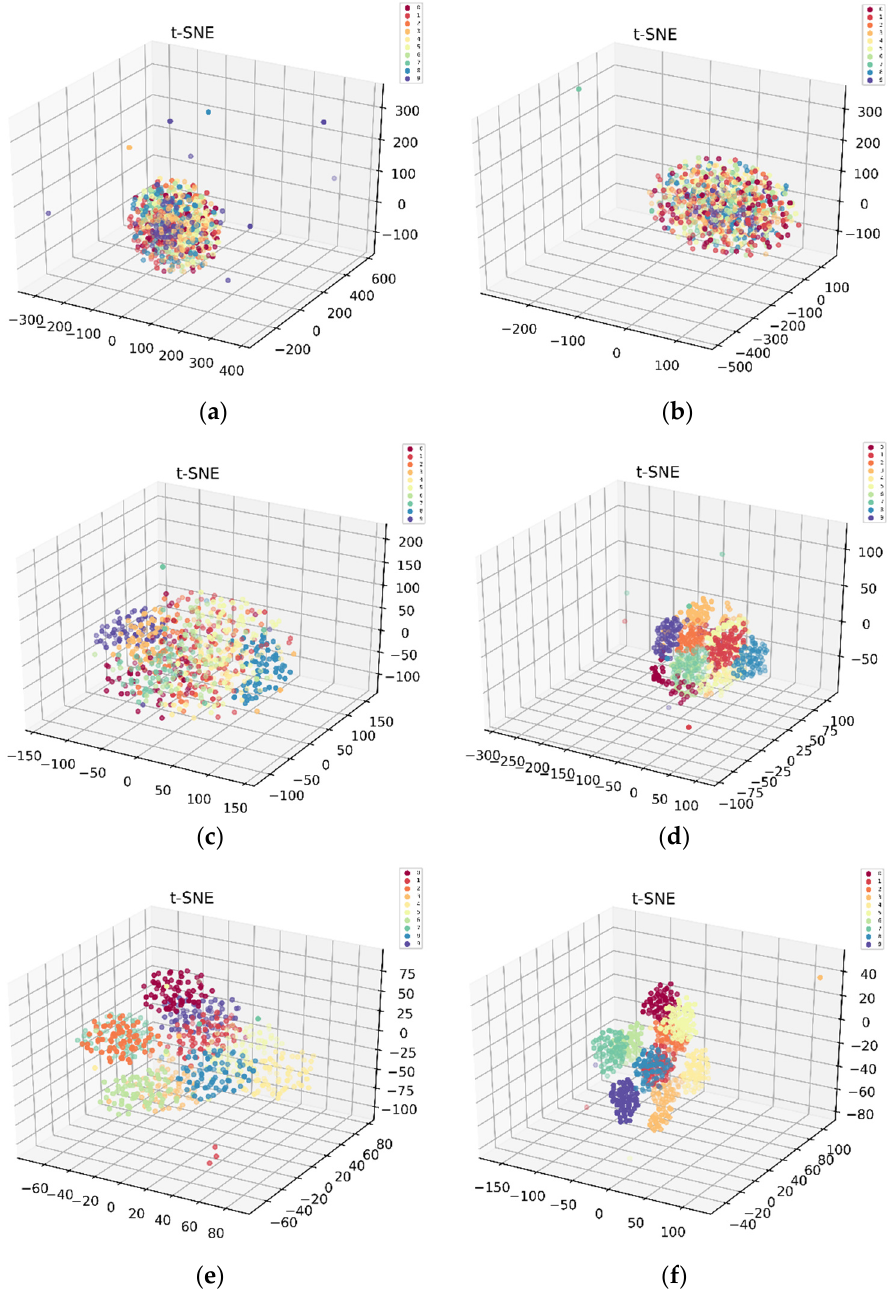
Figure 7. Scatter plots of the feature visualization by t-SNE: ( a ) feature distribution of raw data, ( b ) feature distribution of convolutional layer 1, ( c ) feature distribution of convolutional layer 2, ( d ) feature distribution of convolutional layer 3, ( e ) feature distribution of convolutional layer 4, and ( f ) feature distribution of the fully connected layer.